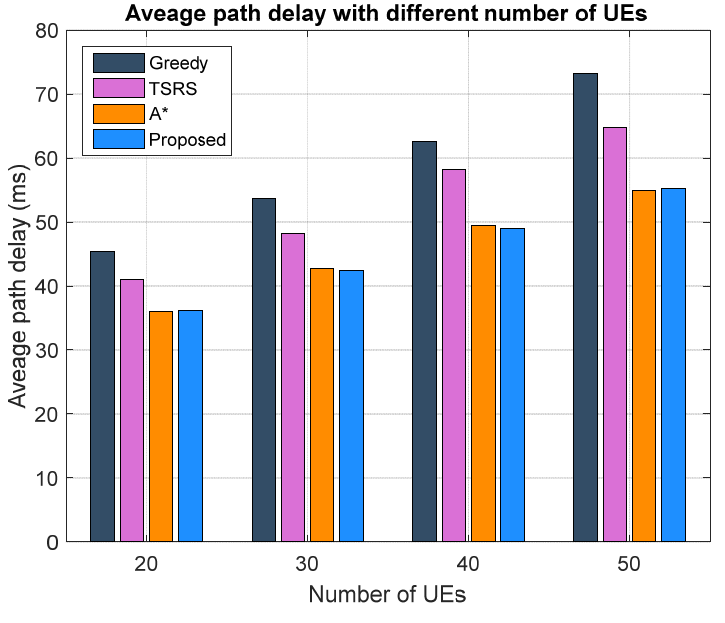
Figure 14. Delay vs. number of UEs.